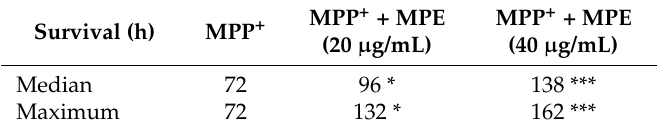
Table 2. Survival (median and maximum) of C. elegans (N2), as compared with 1-methyl-4- phenylpyridinium (MPP + ) treatment (750 μ M). MPE treatment at both 20 and 40 μ g/mL significantly